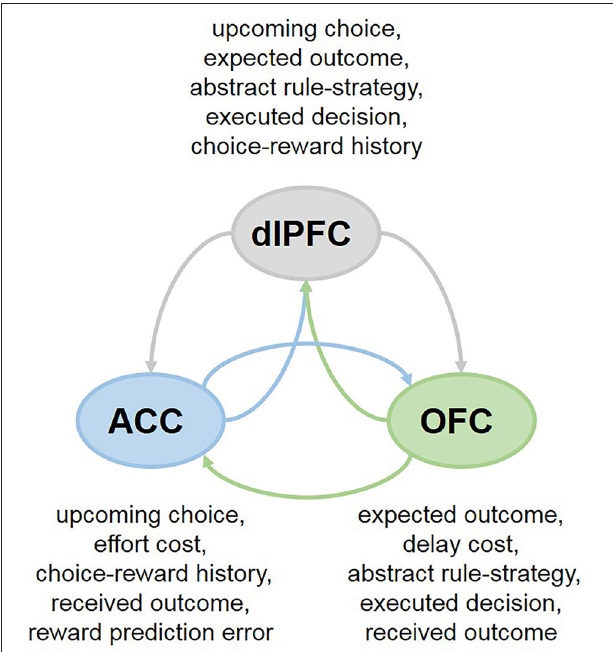
FIGURE 2 | Cooperation between PFC subregions in multi-cue tasks . In many everyday decisions, the options are compared across multiple features simultaneously (ex., by considering current context, needs, available reward types, as well as delay and effort costs). Neurons in different subregions of the PFC exhibit rich response properties, integrating many aspects of the task at hand. The OFC, ACC and dlPFC communicate extensively, sharing the information about presented options, executed decisions and received rewards, which can enable them to assign credit for outcomes to choices on which they are